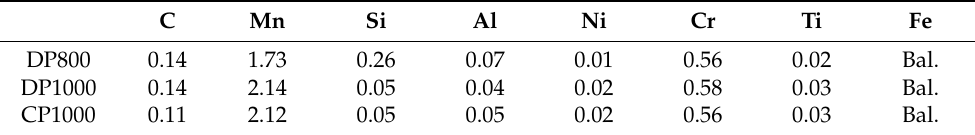
Table 1. Chemical composition of the steels in wt.% used in hydrogen permeation study (EDS-SEM